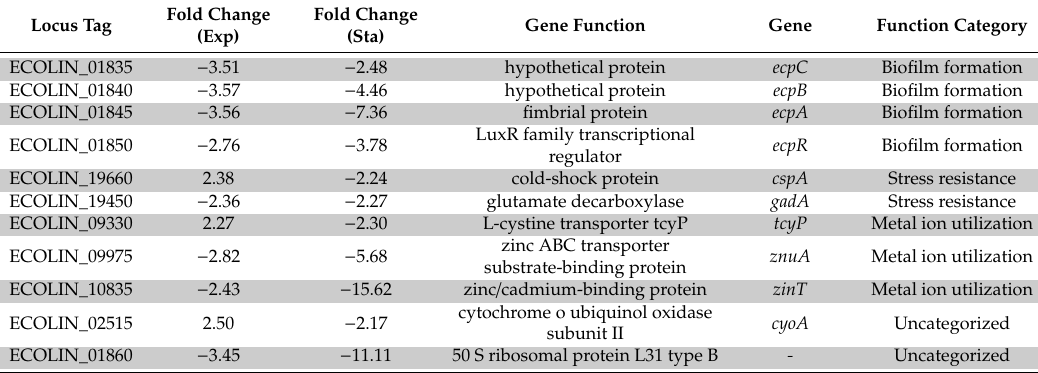
Figure 1. ( A ) The operating orientation of the rotary cell culture system (RCCS) under microgravity (MG) and normal gravity (NG) conditions is shown. ( B ) The growth profiles of EcN at 37 ◦ C in a clinostat under MG and NG conditions are shown. ( C ) Identified di ff erentially expressed genes (DEGs) during the exponential and stationary growth phases are shown in the Venn diagram. Table 1. DEGs presented in both MG and NG. All DEGs that overlapped the two gravity conditions are listed as fold change values and the categorized group indicated. Fold change value are relative to the original value. The positive fold change values are provided as the expression ratio of MG to NG. The negative fold change values are provided as the expression ratio of NG to